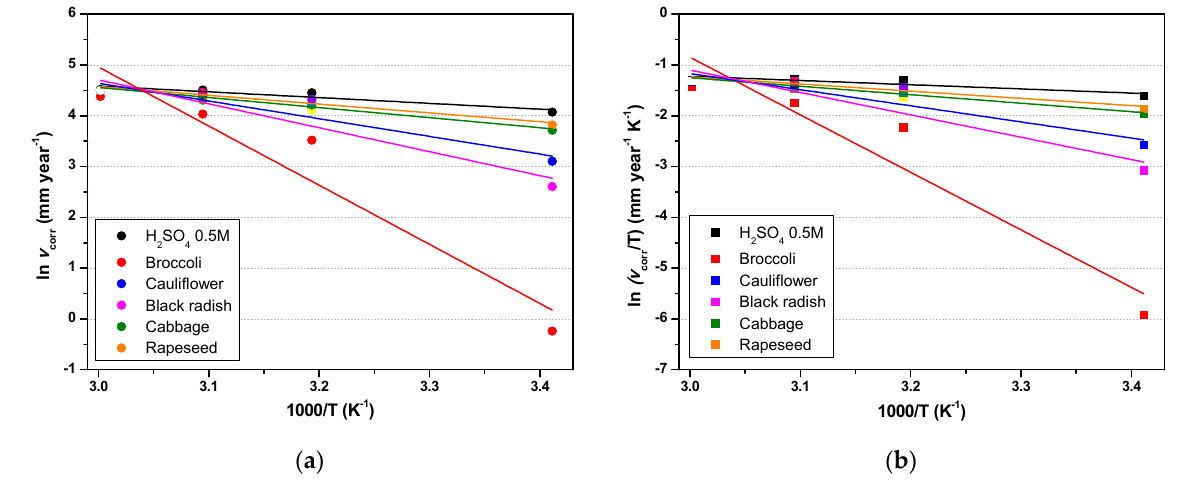
Figure 5. Arrhenius plots for steel in 0.5 M H 2 SO 4 in the absence and presence of Brassicaceae extracts Table 5. Activation parameters for steel in 0.5 M H 2 SO 4 in the absence and presence of Brassicaceae extracts A.